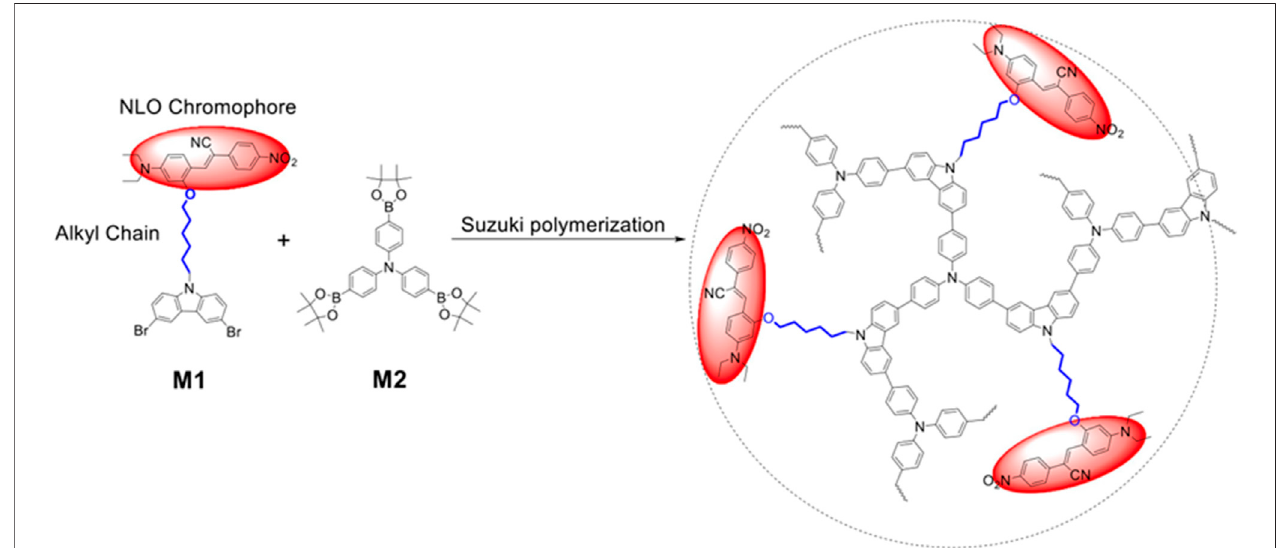
FIGURE 6 | Synthesis of hyperbranched polymers by Suzuki – Miyaura reaction (Zhang et al., 2020c).